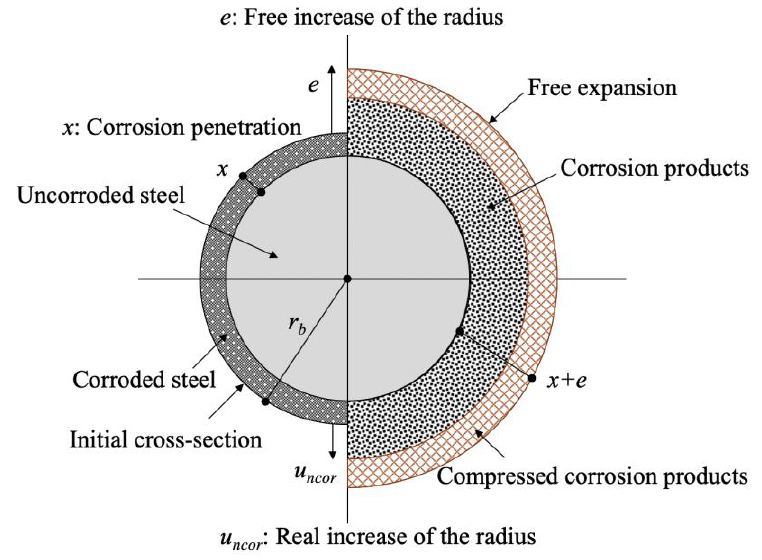
Figure 1. Schematic of the corrosion model for volume increase with corrosion products [18].